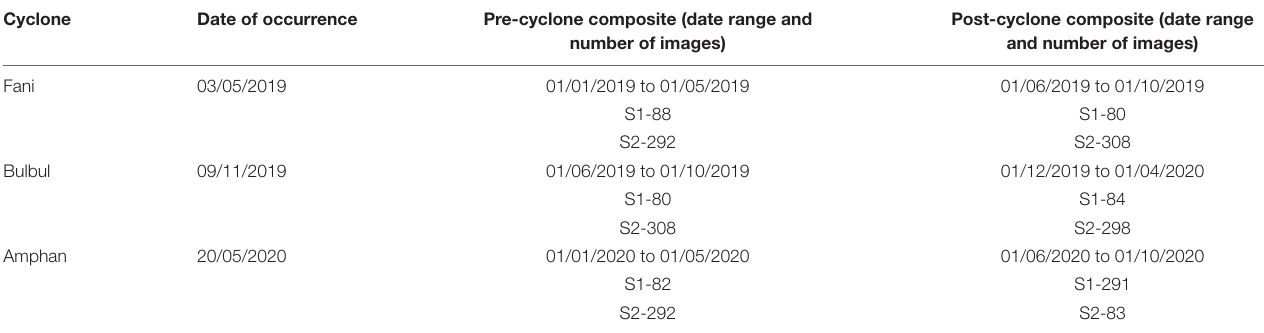
number of images)